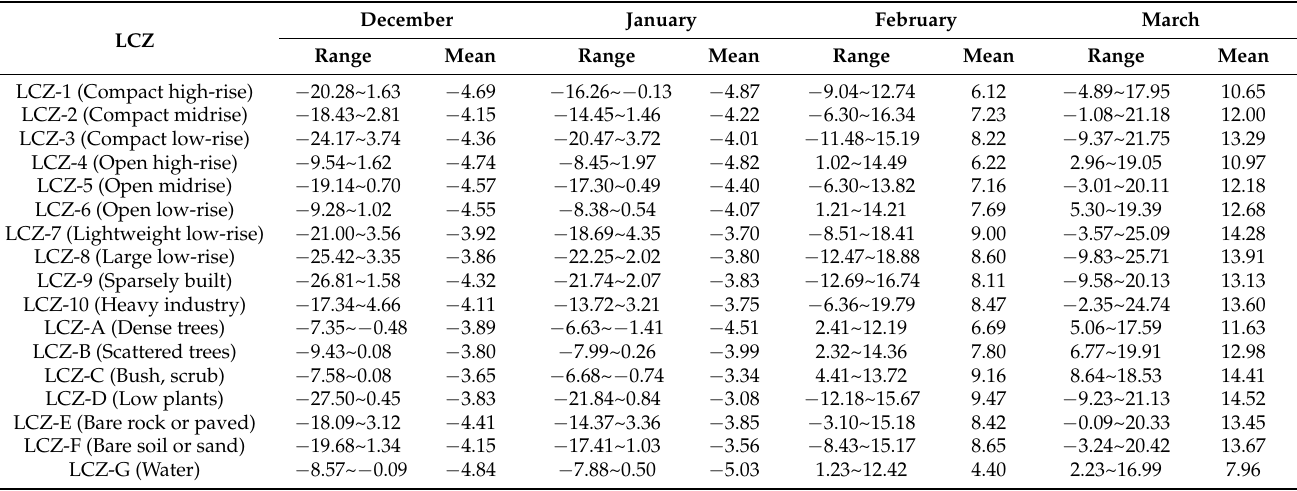
Table A1. Land Surface Temperature of Different Local Climate Zones in Different Months within Urban Context.